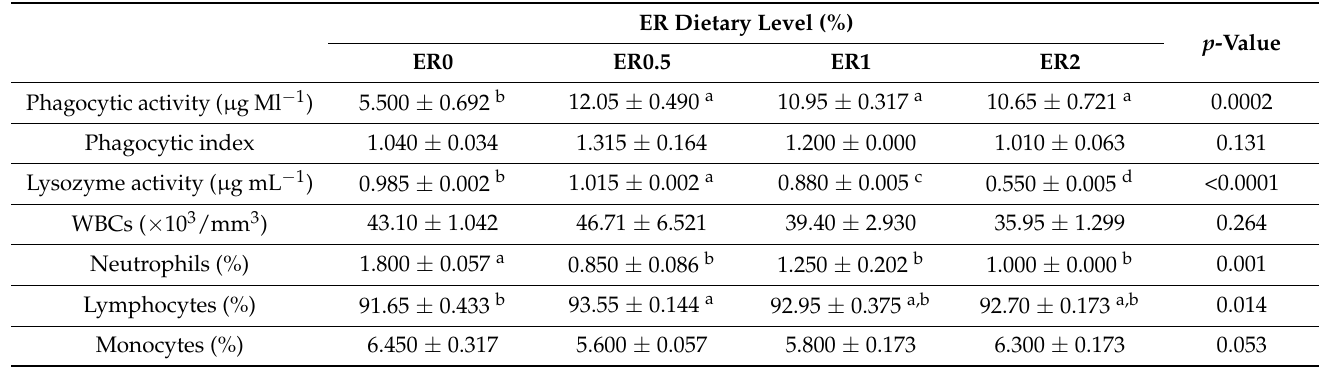
11 of 23 Table 7. The immune response of Red tilapia fed different dietary levels of ER. ER Dietary Level (%) p -Value ER0